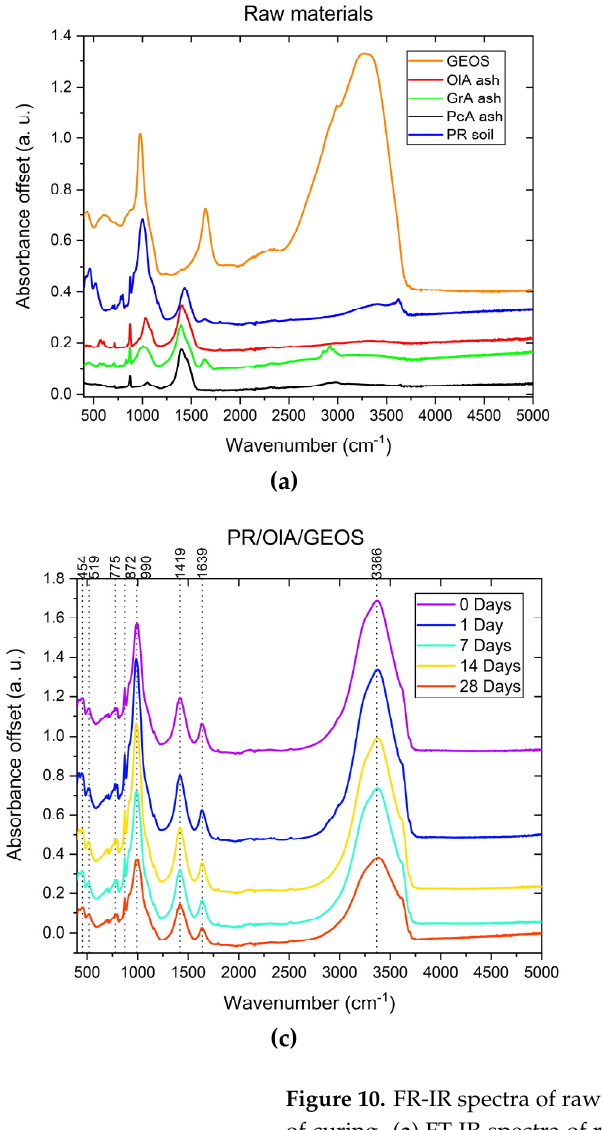
H/C-A-S-H gels ( b ).